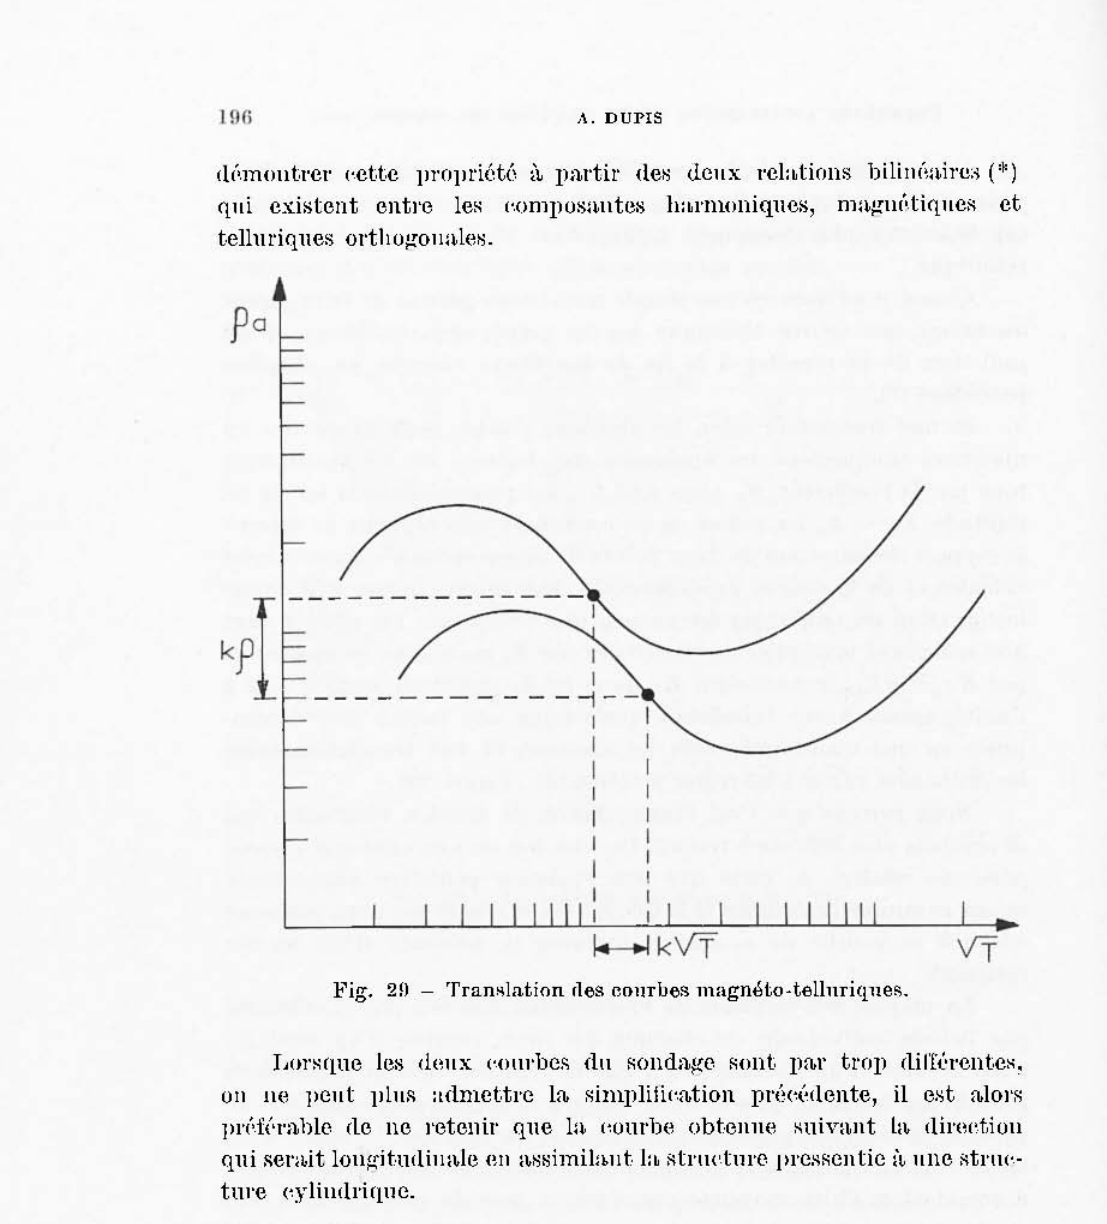
Fig. 2!l - Tran~lation (les cOllrùes